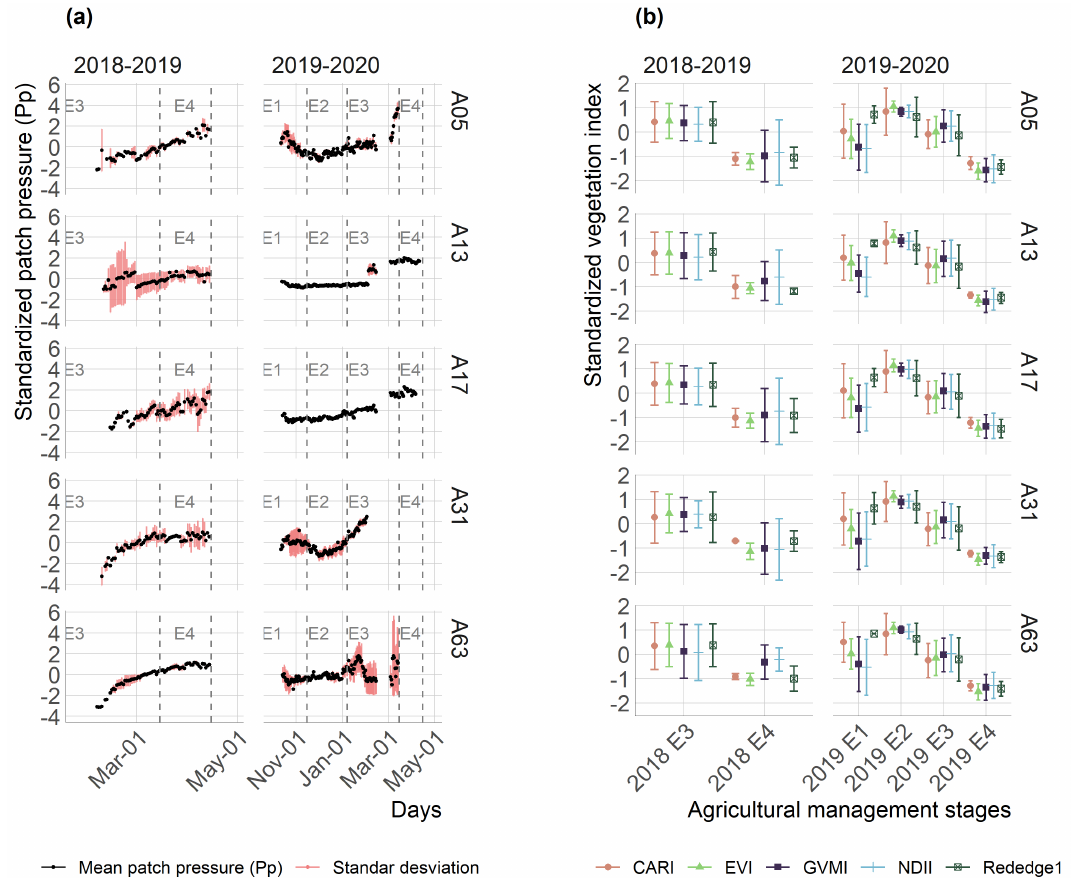
Figure 6. ( a ) Average patch pressure (Pp) for each tree (black line) and its standard deviation (red line). ( b ) values of the vegetation indices for each tree grouped for each stage of agricultural management through the average and standard